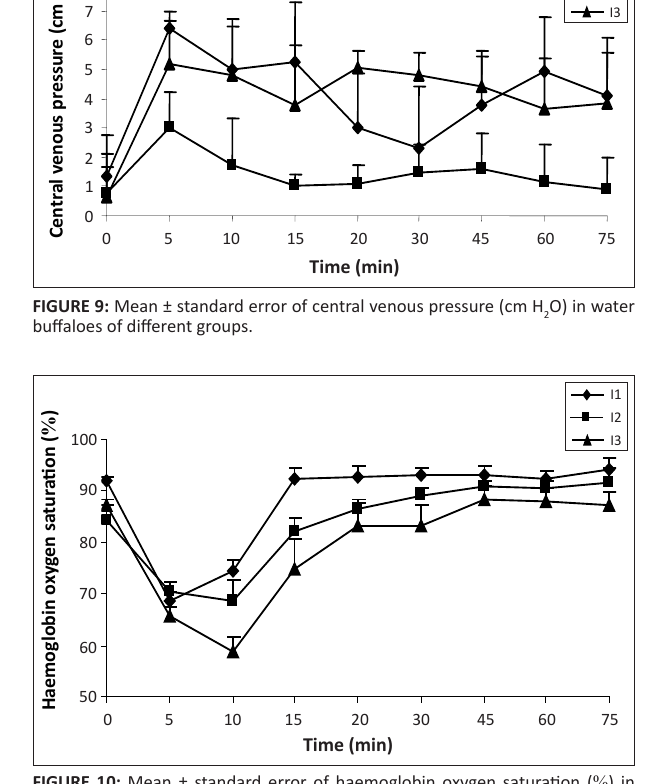
FIGURE 10: Mean ± standard error of haemoglobin oxygen saturation ( % ) in water buffaloes of different